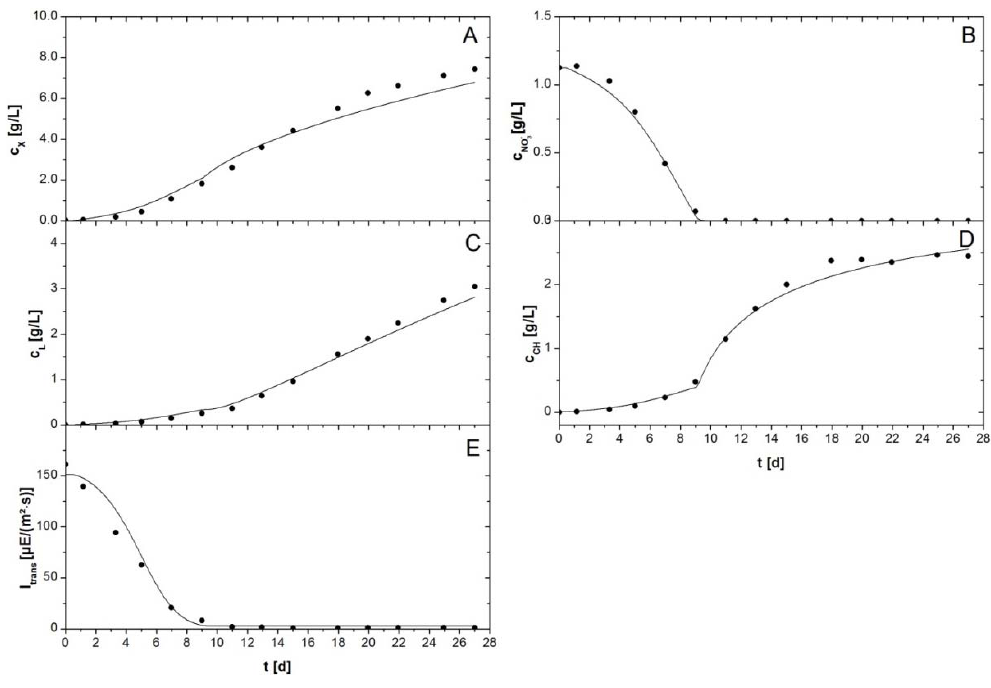
Figure 4. Batch cultivation of P. tricornutum with a NaNO starting concentration of 1.56 g/L. 3 Symbols indicate experimental data. Lines represent simulated data. ( A ) Biomass ; ( B ) Nitrate concentration (cid:1855) ; ( C ) Lipid concentration (cid:1855) , comprises concentration (cid:1855) (cid:3025) (cid:3015)(cid:3016) (cid:3119)(cid:3127) (cid:3013) concentration of membrane lipids and TAGs; ( D ) Carbohydrate concentration (cid:1855) , (cid:3004)(cid:3009) comprises concentrations of functional and storage carbohydrates; and ( E ) Irradiance of transmitted light (cid:1835) . (cid:3047)(cid:3045)(cid:3028)(cid:3041)(cid:3046)